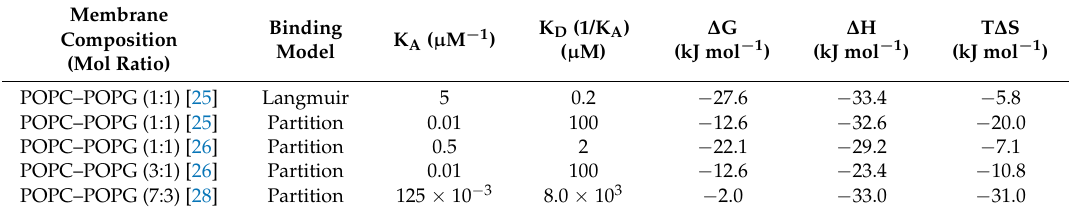
Thermodynamic parameters determined by isothermal titration calorimetry (ITC) measurements of the binding of Gomesin to membranes composed of POPC with different fractions of POPG. Data from binding isotherms was fitted using a Langmuir model or a partition model. Membrane